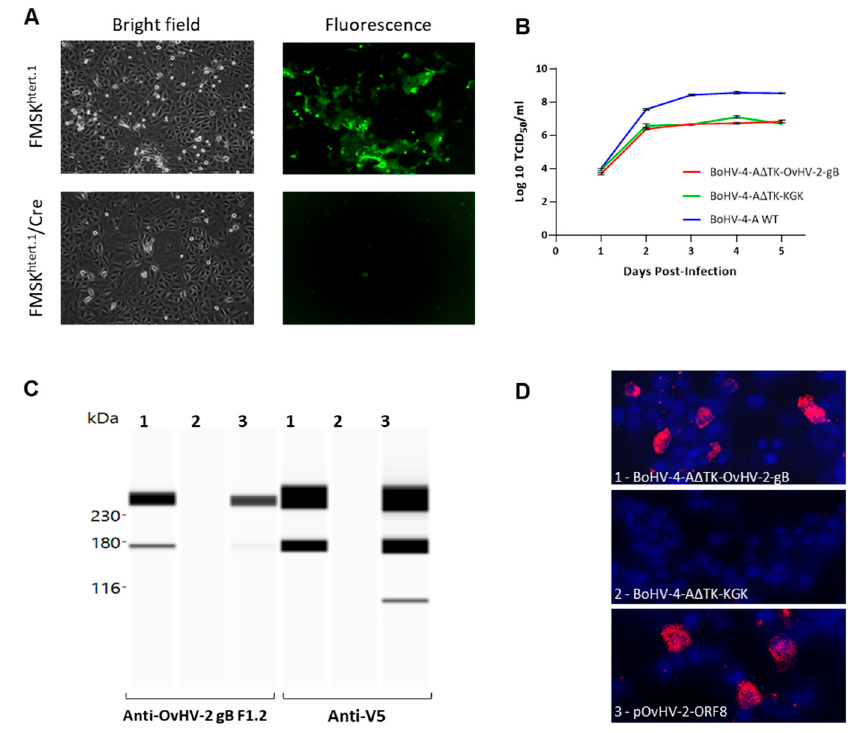
Figure 2. BoHV-4-A ∆ TK-OvHV-2-gB infectivity and OvHV-2 gB expression. ( A ) Representative microscopic images of plaques formed by virus reconstituted from pBAC-BoHV-4-A ∆ TK-OvHV-2-gB in FMSK htert.1 and FMSK htert.1 /Cre cells. ( B ) Replication kinetics of BoHV-4-A ∆ TK-OvHV-2-gB, BoHV-4-A ∆ TK-KGK, and BoHV-4-A in FMSK htert.1 cells. Growth curves show mean TCID50/mL data from triplicate measurements. Error bars are SEM. Expression of OvHV-2 gB was examined in HEK293T cells transfected with (#1) BoHV-4-A ∆ TK-OvHV-2-gB, (#2) BoHV-4-A ∆ TK-KGK, or (#3) pOvHV-2-ORF8 (positive control) by immunoblotting ( C ) and immunofluorescence ( D ). For immunoblotting, reaction with both anti-OvHV-2 (F1.2) and anti-V5 antibodies are shown ( C ). For immunofluorescence, reaction with the anti-OvHV-2 (F1.2) is shown in representative confocal images (20 × ); OvHV-2 gB is stained in red (Alexa Fluor TM 594 goat anti-mouse IgG (H+L), used as secondary antibody) and cell nuclei in blue